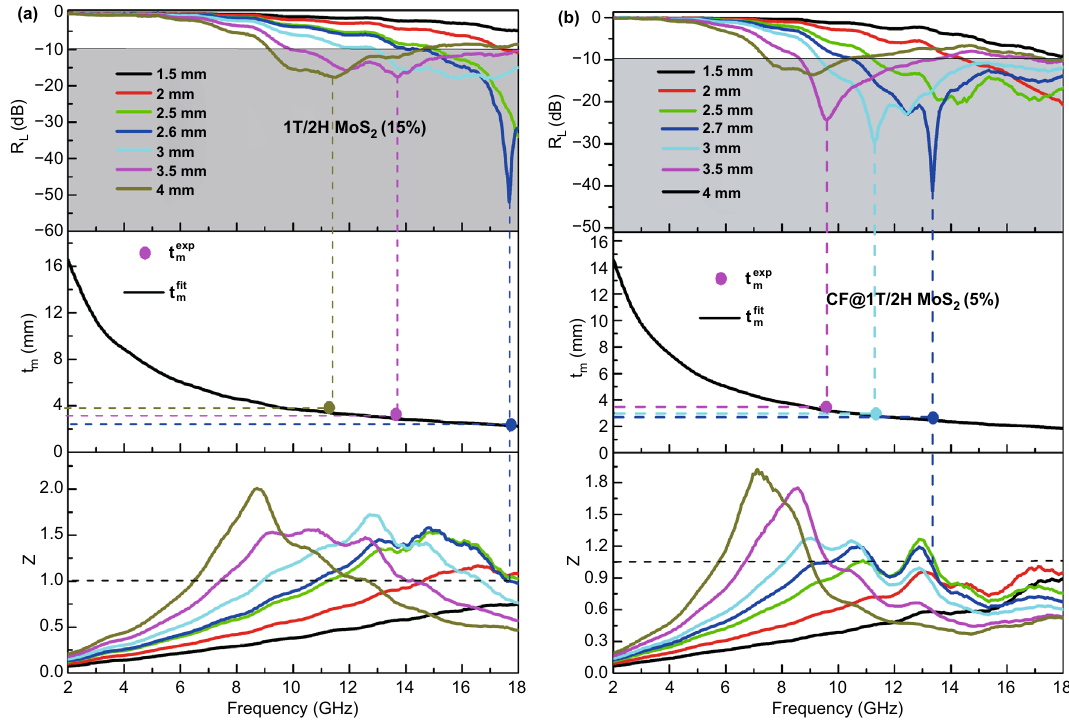
Fig. 8 Dependence of the matching thickness ( t m ) on frequency ( f m ) under λ/4 and normalized input impedance of 1T/2H MoS 2 (15%) and CF@1T/2H